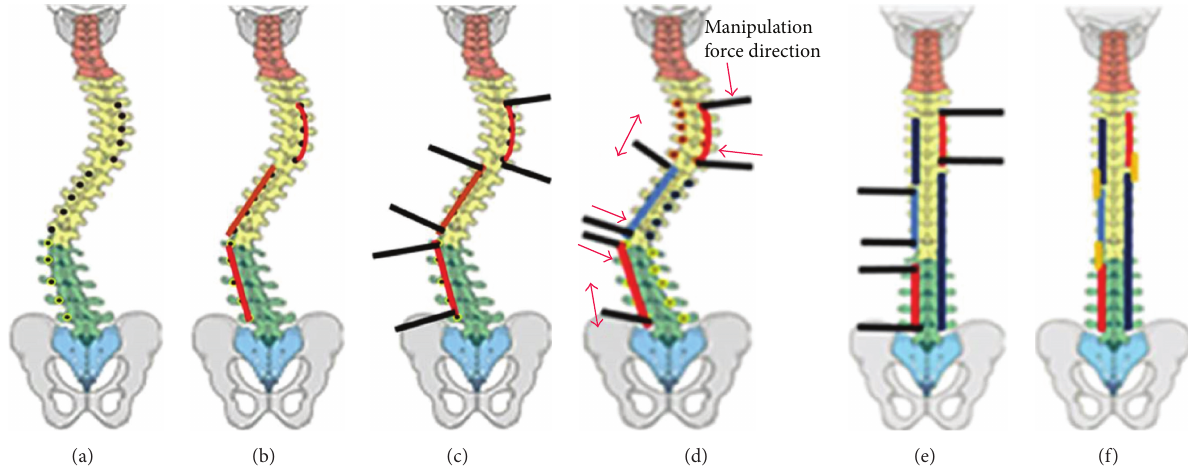
Figure 1: Rod and screw corrective manipulation technique procedure. (a) Pedicle screw placement. (b) Correction rod placement. (c) Correction bar placement. (d) Correction maneuver. (e) Correction rod placement. (f) Connecting rod placement.